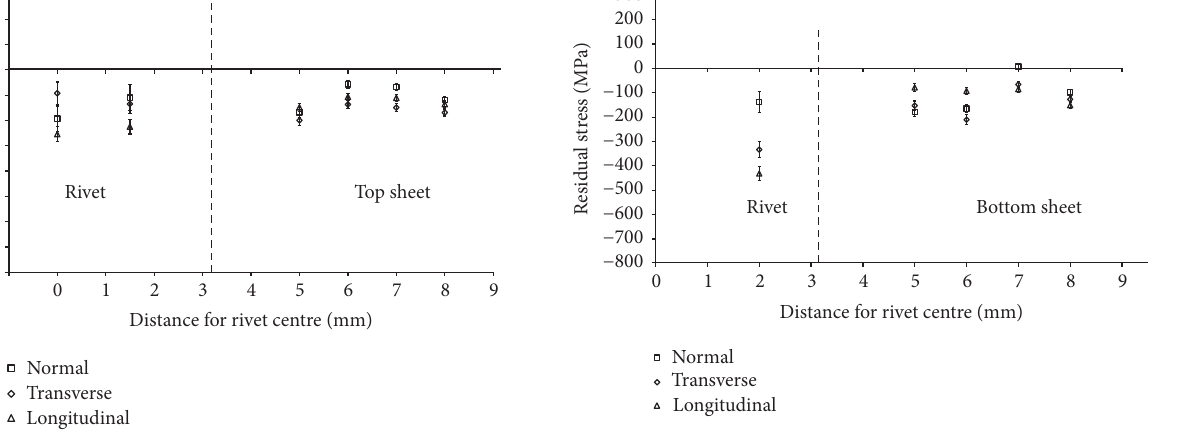
Figure 11: Distribution of residual in the rivet head and top sheet of joint II along FF line as depicted in Figure 5(a).